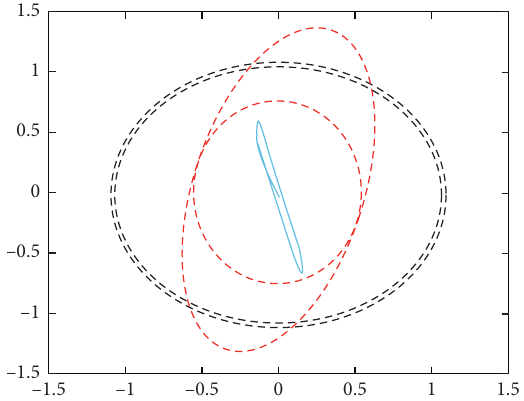
Figure 4: The ellipsoidal bound I and state trajectory of system (58) for Case